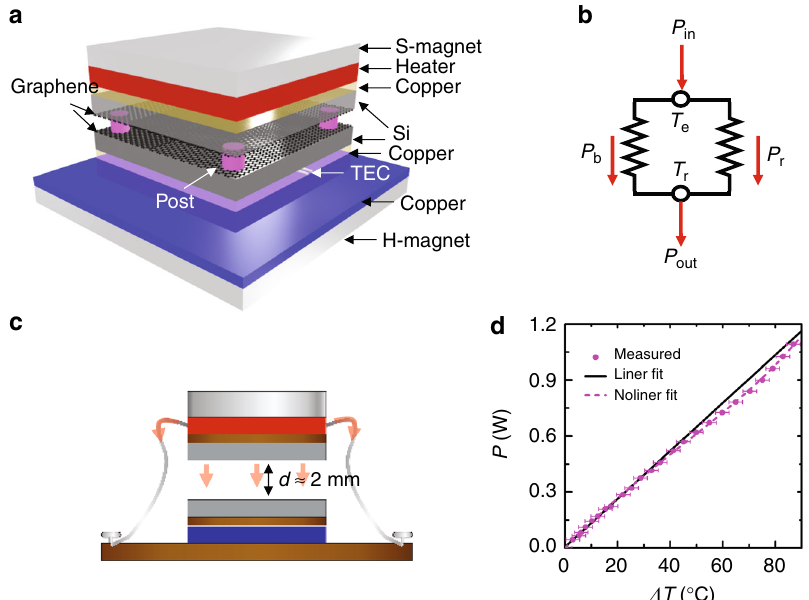
Fig. 1 Measurement setup. a A schematic of the home-made measurement setup. From top to bottom, the emitter side consists of S-magnet, heater, copper spreader, and Si/Gr and the receiver side consisting of Gr/Si, copper spreader, TEC layer, copper spreader, and H-magnet. Four photoresist posts are used to separate the emitter and the receiver. b The equivalent thermal circuit of our measurement setup. The input power P in is split into the background branch with power P b and the near- fi eld radiation with power P r . c Schematic of the background heat loss measurement. The receiver is maintained at 30 °C and displaced from the emitter at a macroscopic vacuum distance of 2 mm. The input power (heat) will be dissipated along the metal wires and via radiation. d The relation of input power with the temperature increment of the emitter. The experimental data points are denoted by the dots and the solid/dashed line represents the linear/non-linear fi tting, from which we obtain the background heat loss P b ( Δ T ). The error bar for the temperature is 2.3 °C, derived from the fi ve times repeating measurement. Figure 1 by Yang J et